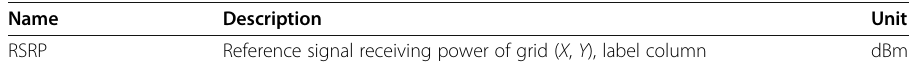
Table 4 Description of RSRP label data table